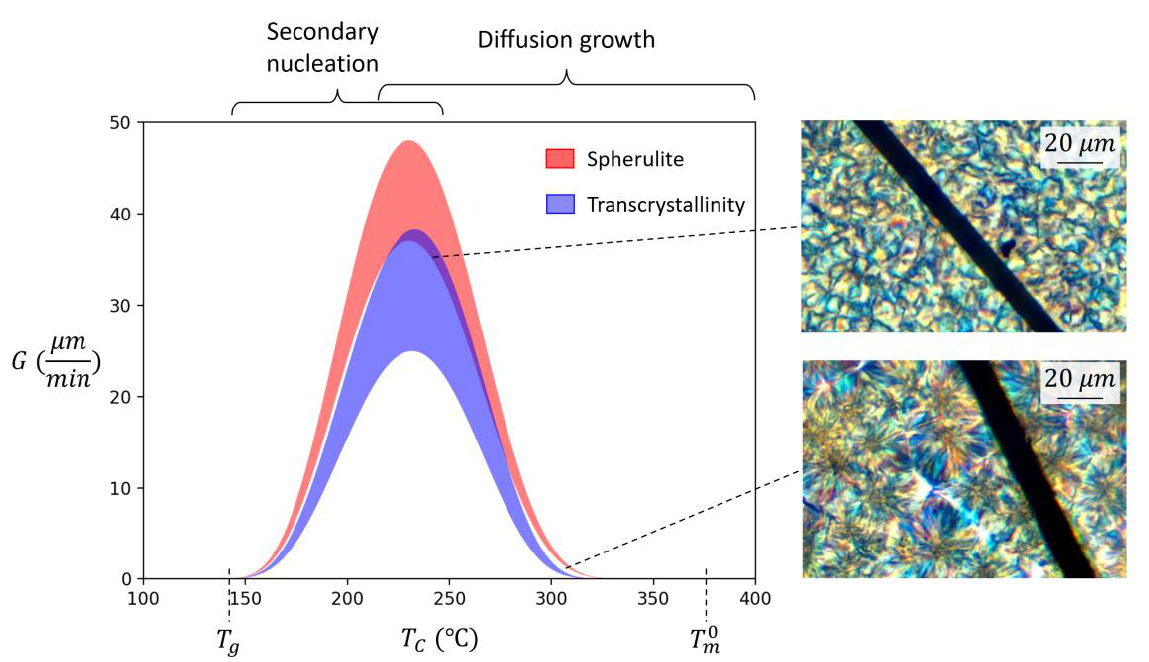
Figure 8. Comparison of growth rate as a function of temperature for spherulitic and transcrystallinity growths. Examples of final morphologies at different temperatures are superposed on the graph.